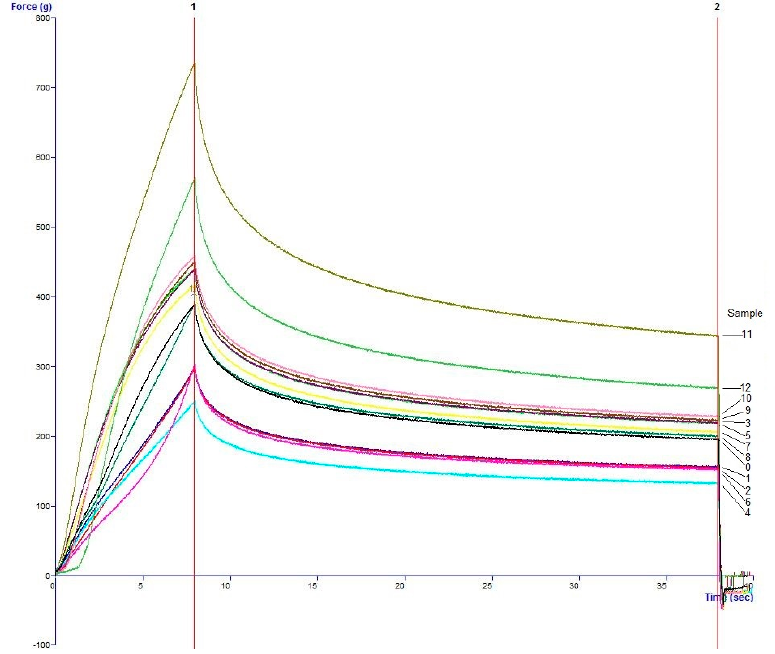
Table 4. Firmness of sponge cakes in air-cooled condition.